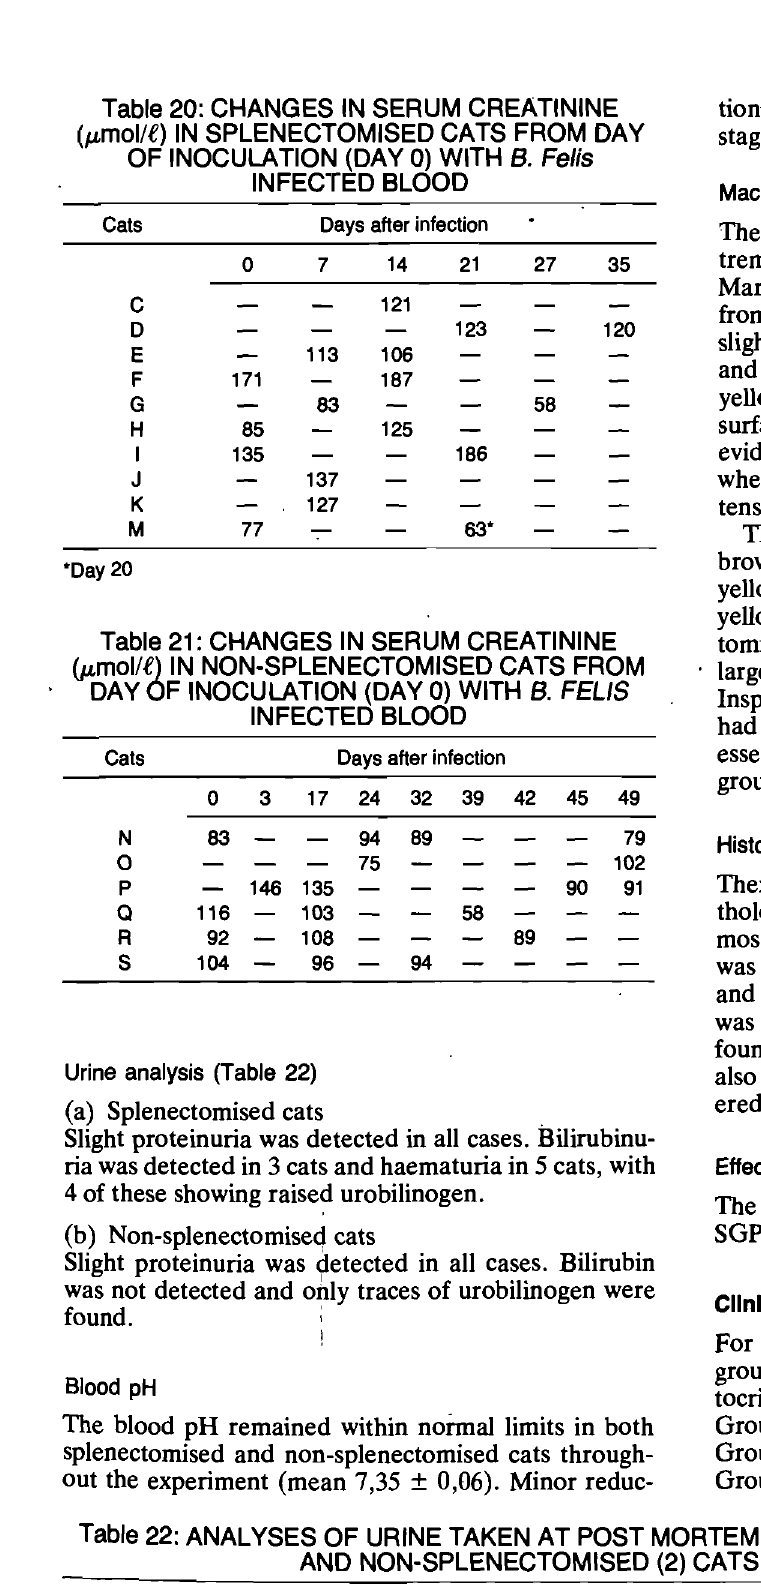
Table 22: ANALYSES OF URINE TAKEN AT POST MORTEM EXAMINATION FROM SPLENECTOMISED (1) AND NON-SPLENECTOMISED (2) CATS INFECTED WITH B.